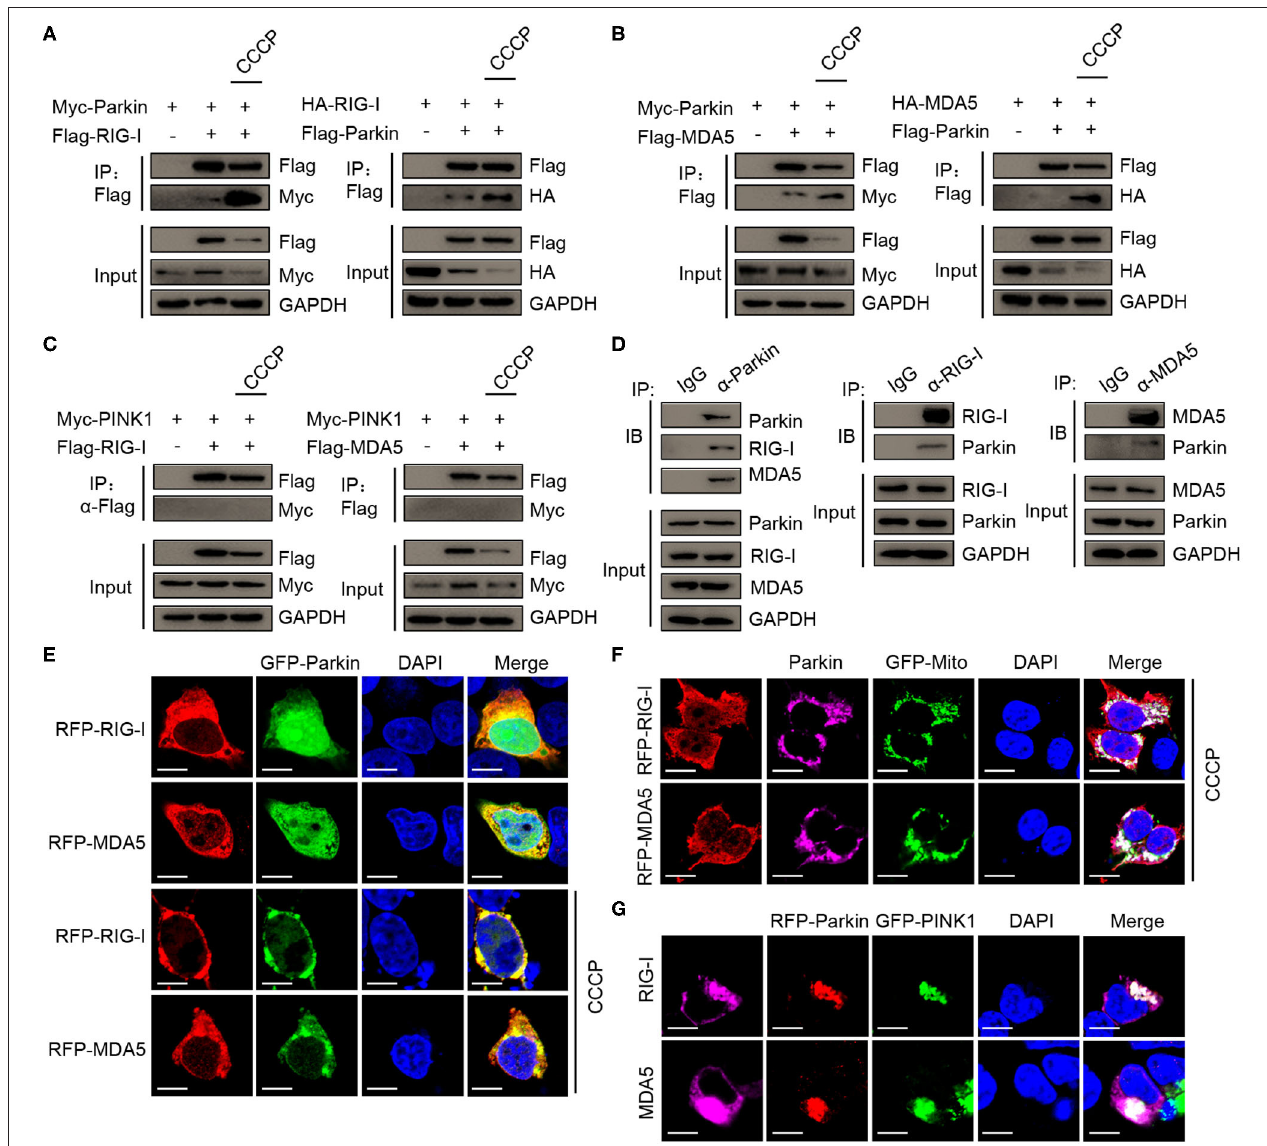
FIGURE 5 | CCCP promotes the interaction between Parkin and RIG-I or MDA5 on mitochondria. (A) 293T cells were co-transfected with Myc-Parkin and vector or Flag-RIG-I, or co-transfected with HA-RIG-I and vector or Flag-Parkin. 24h post-transfection, untreated or treated with CCCP (10 µ M) for 12h, and then subjected to IP and IB analysis. (B) 293T cells were co-transfected with Myc-Parkin and vector or Flag-MDA5, or co-transfected with HA-MDA5 and vector or Flag-Parkin. 24h post-transfection, untreated, or treated with CCCP (10 µ M) for 12h, and then subjected to IP and IB analysis. (C) 293T cells were co-transfected with Myc-PINK1 and vector, Flag-RIG-I, or Flag-MDA5. 24h post-transfection, untreated or treated with CCCP (10 µ M) for 12h, and then subjected to IP and IB analysis. (D) HEK293 cells were stimulated with SeV for 10h, and then whole cell lysates were collected, immunoprecipitated with indicated antibodies and subjected to IB analysis. (E) 293T cells were co-transfected with GFP-Parkin and RFP-RIG-I, or RFP-MDA5. 24h post-transfection, untreated, or treated with CCCP (10 µ M) for 6h, and then subjected to IF analysis. Scale bar is 10 µ m. (F) Parkin and GFP-Mito were co-transfected with RFP-RIG-I or RFP-MDA5 for 24h in 293T cell, treated with CCCP (10 µ M) for 6h, and then subjected to IF analysis. Scale bar is 10 µ m. (G) GFP-PINK1 and RFP-Parkin were co-transfected with RIG-I or MDA5 for 24h in 293T cells, then subjected to IF analysis. Scale bar is 10 µ m.